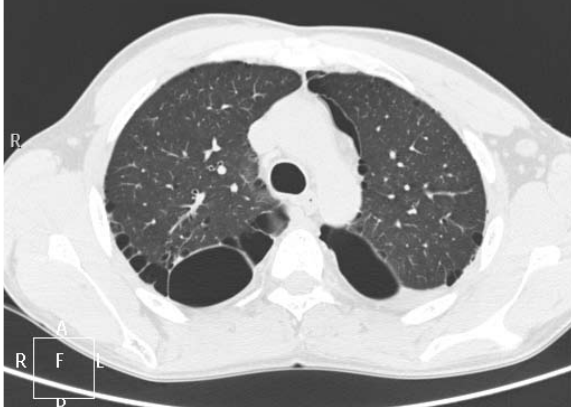
Fig. 2. Axial computed tomography scan on lung windows. Large bilateral paraseptal bullae are demonstrated with residual antero-medial